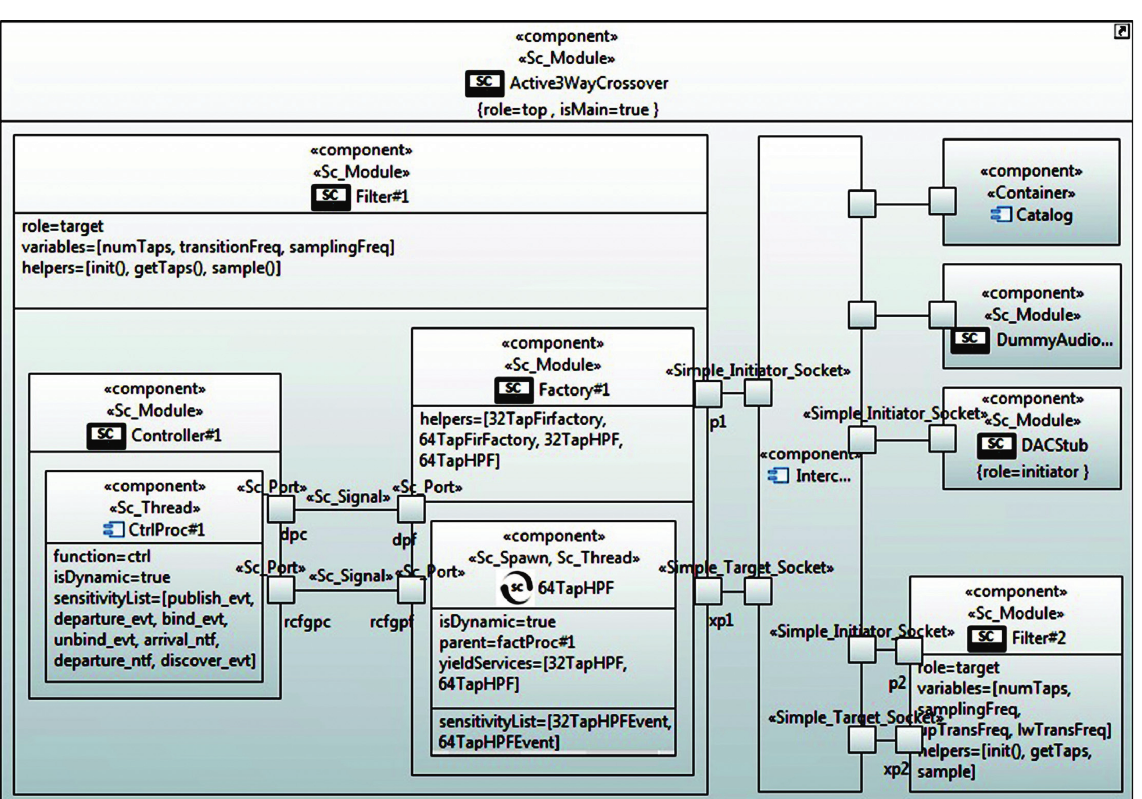
Figure 17: SystemC/TLM simulation